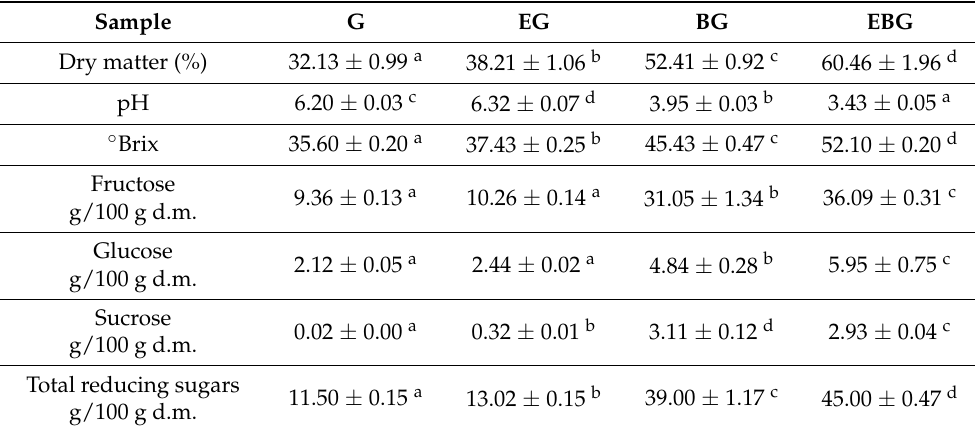
Table 1. Physicochemical characterization of white and black garlic from conventional and organic cultivation.